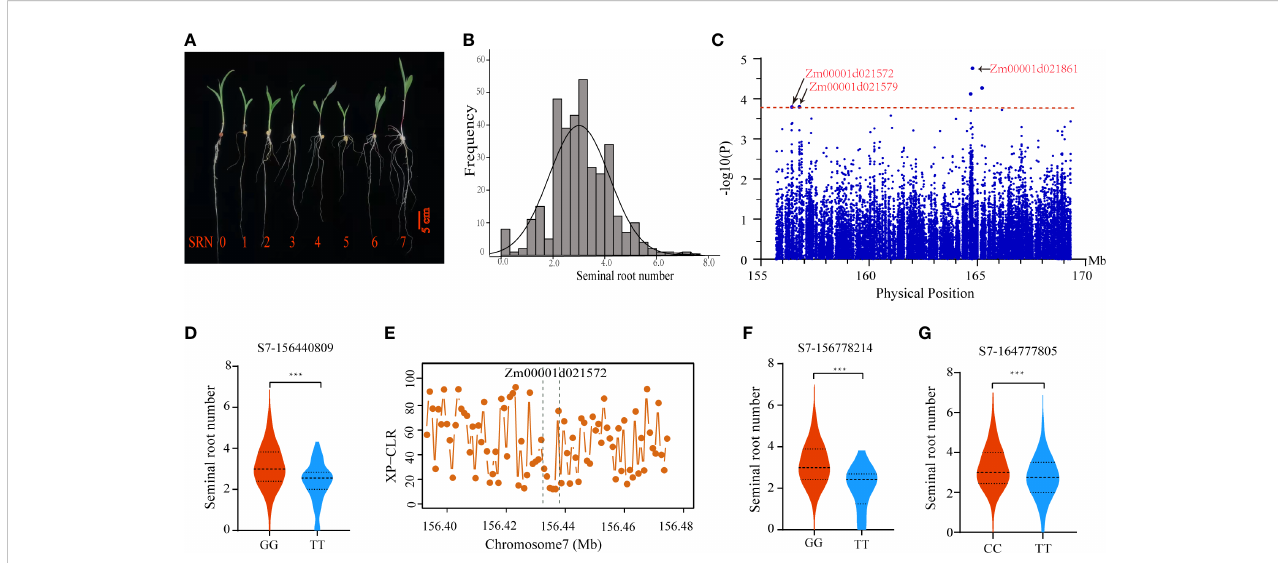
FIGURE 4 Identi fi cation of candidate genes underlying SRN. (A) SRN phenotypes of representative inbred lines in the association panel. (B) Frequency distribution of SRN in the association panel. (C) Manhattan plot of regional association mapping. (D) Phenotypic analysis of inbred lines with different haplotypes for associated SNPs (S7_156440809). (E) XP-CLR scores of Zm00001d021572 selected during maize domestication. The two dashed lines represent the physical position of Zm00001d021572. (F, G) Phenotypic analysis of inbred lines with different haplotypes for associated SNPs (S7_156778214 and S7_164777805). Center lines indicate the medians and lines above and below the median are 25 th and 75 th percentiles, and the whiskers extend 1.5 times the interquartile range from the 25 th and 75 th percentiles. Statistical signi fi cance was determined using two-sided t -tests. ***, P <